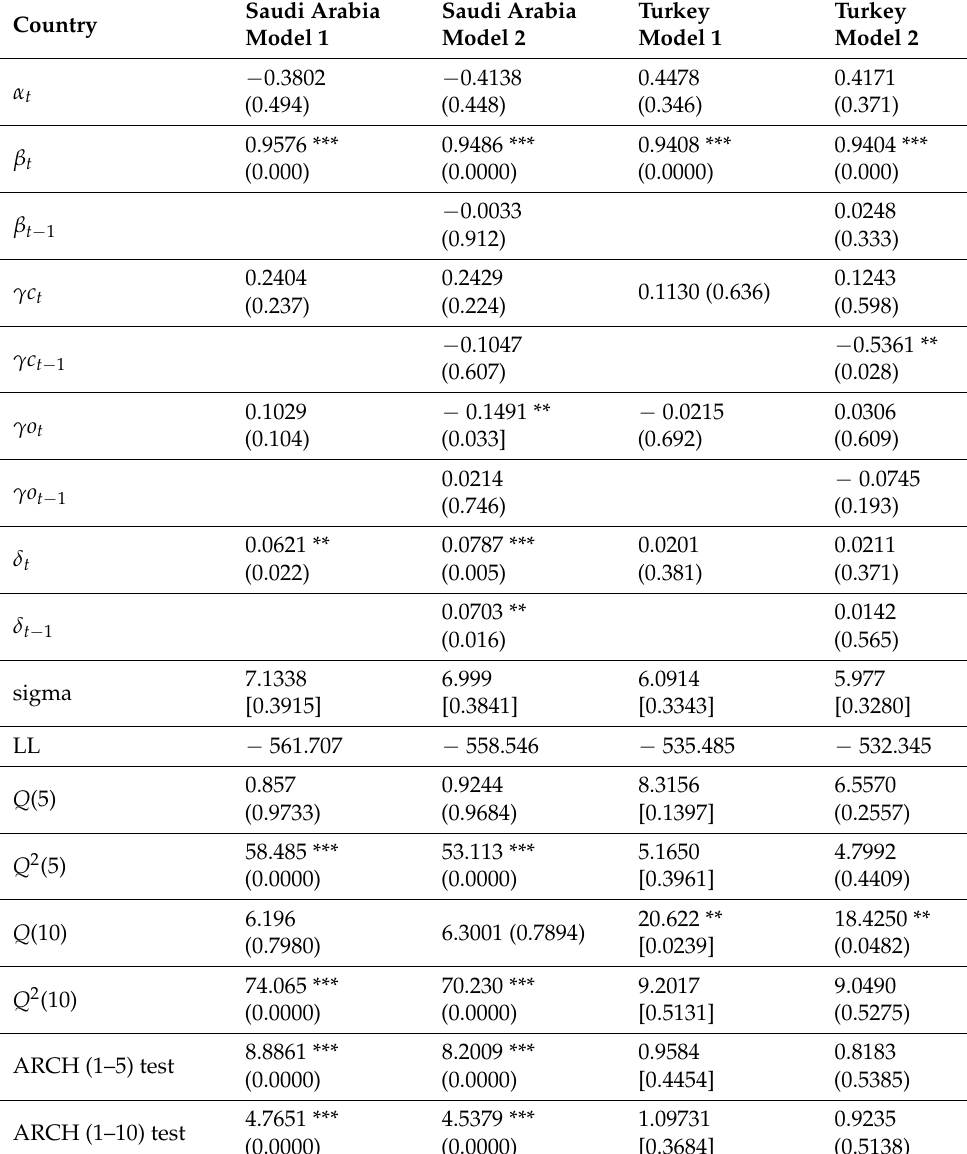
Table 5. Estimates of ICAPM with composite risk ratings, oil prices, and VIX index values.